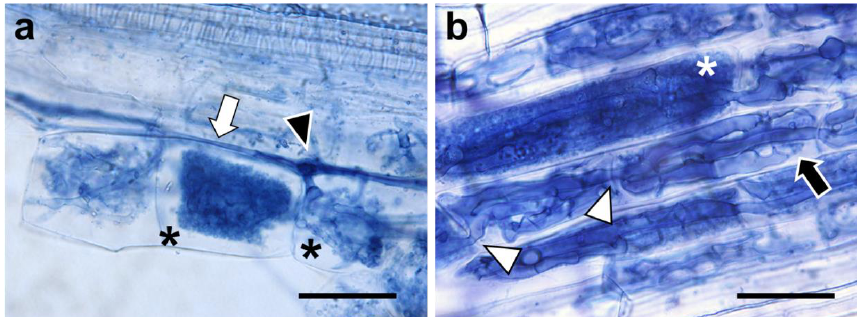
Figure 1. Arbuscular mycorrhizal (AM) morphotypes formed in tomato roots colonized by Rhizophagus irregularis or Gigaspora margarita . Tomato roots inoculated with R. irregularis ( a ) or G. margarita ( b ) were collected five weeks post-inoculation (wpi). The collected root samples were stained with 0.05% trypan blue. Scales: 20 µm. White arrow, intercellular hypha; black arrowhead, intercellular hypha penetrating the tomato cortical cell; asterisks, arbuscules; black arrow, hyphal coil; white arrowheads, intracellular hypha penetrating the adjacent tomato cortical cells.